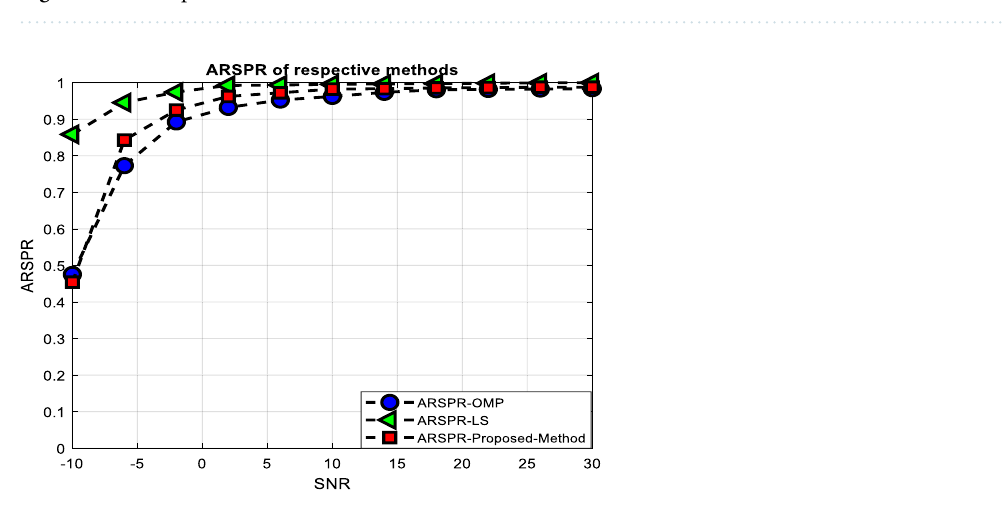
Figure 4. ARSPR performance versus the